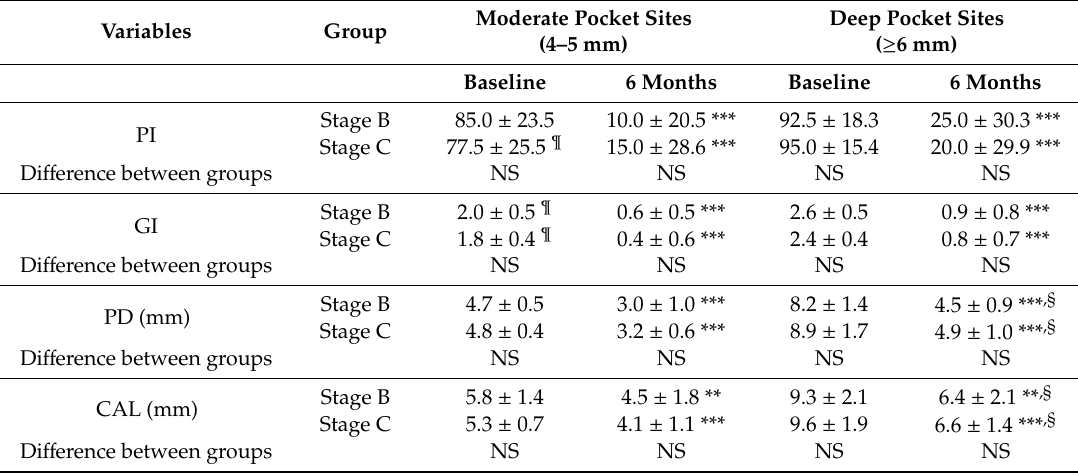
Table 2. Changes in clinical variables (mean ± SD) over the 6-month experimental period (gingival crevicular fluid (GCF) sampling